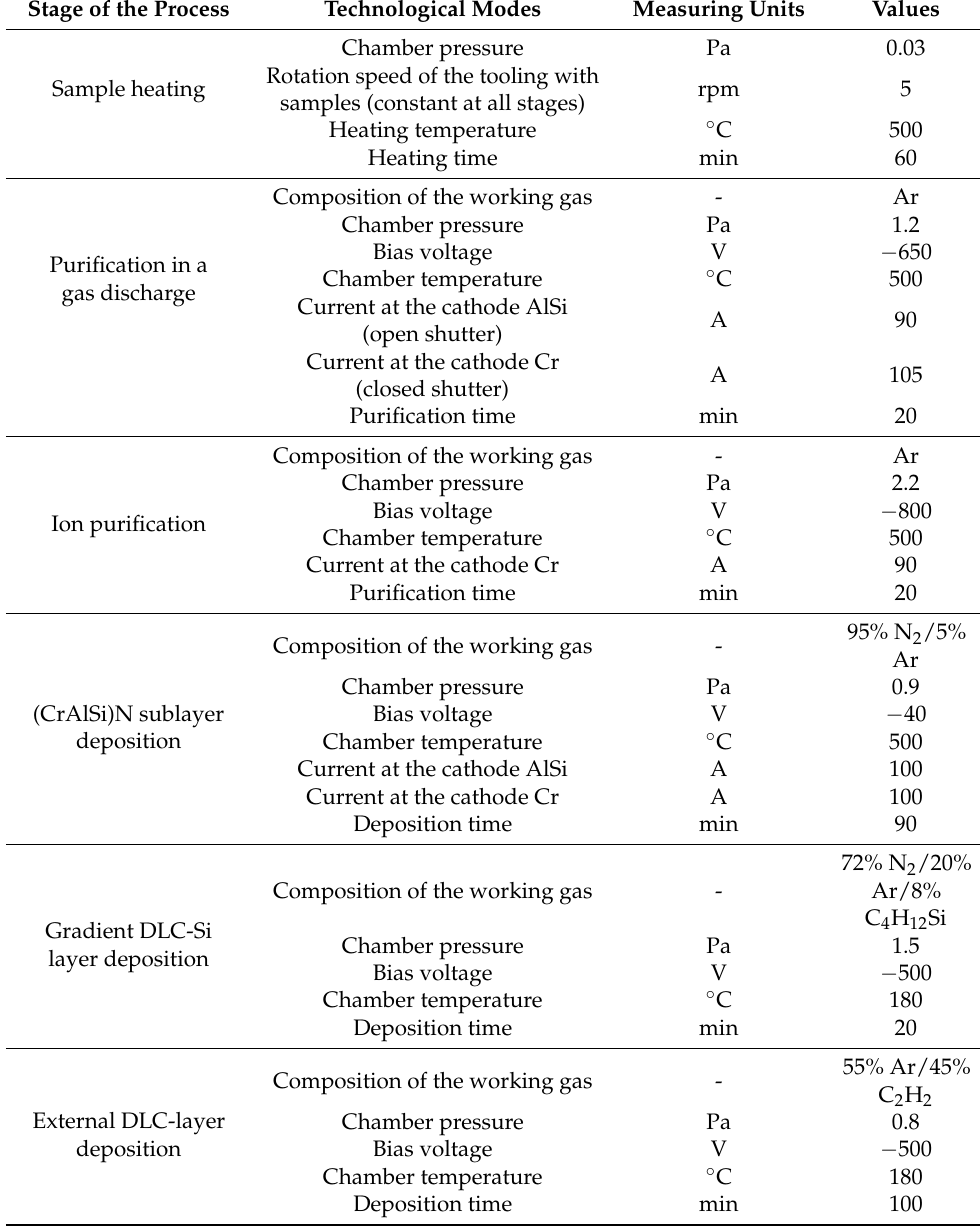
Table 2. Range of factors of technological cycle of coating